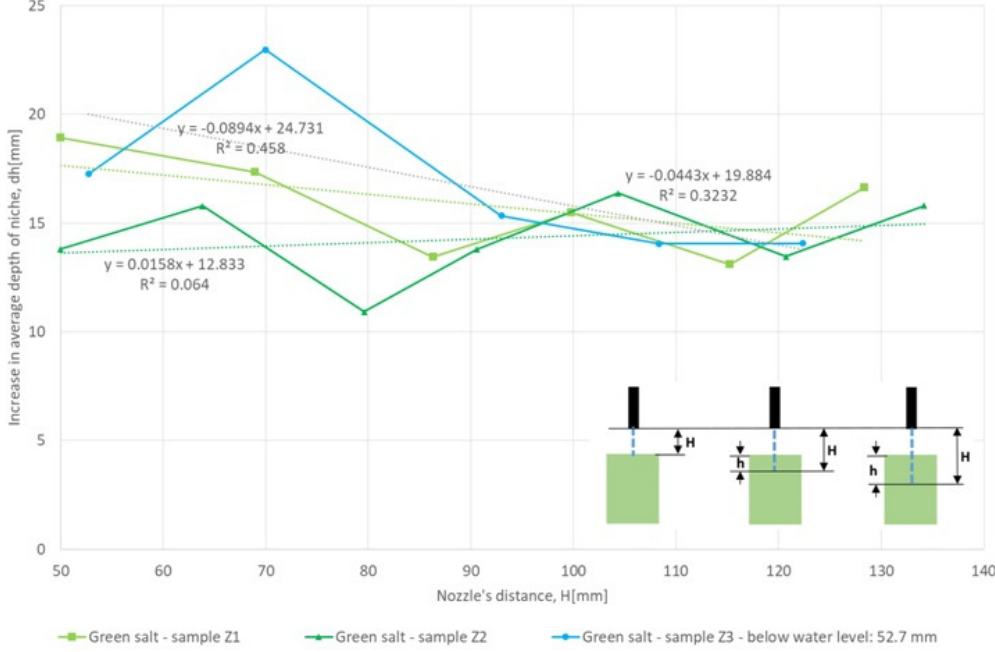
Figure 8. Dependence of the nozzle’s distance from the salt contact surface and average increases in niche depth after one cycle. Nozzle’s displacement velocity v = 100 mm/min. Water jet pressure p = 500 bar.